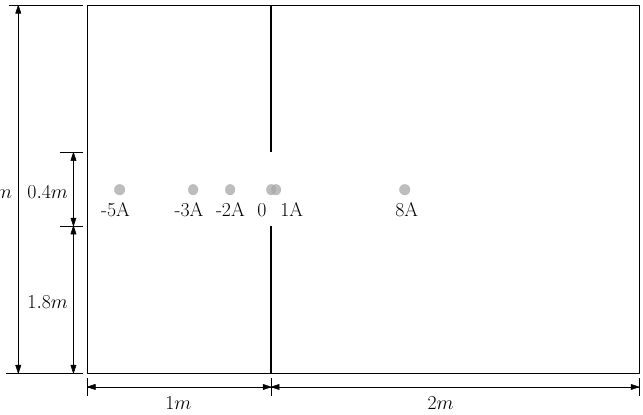
Figure 22. Sketch of the computational domain for the 3D dambreak on a dry plane test case including the position of the wave gauges.